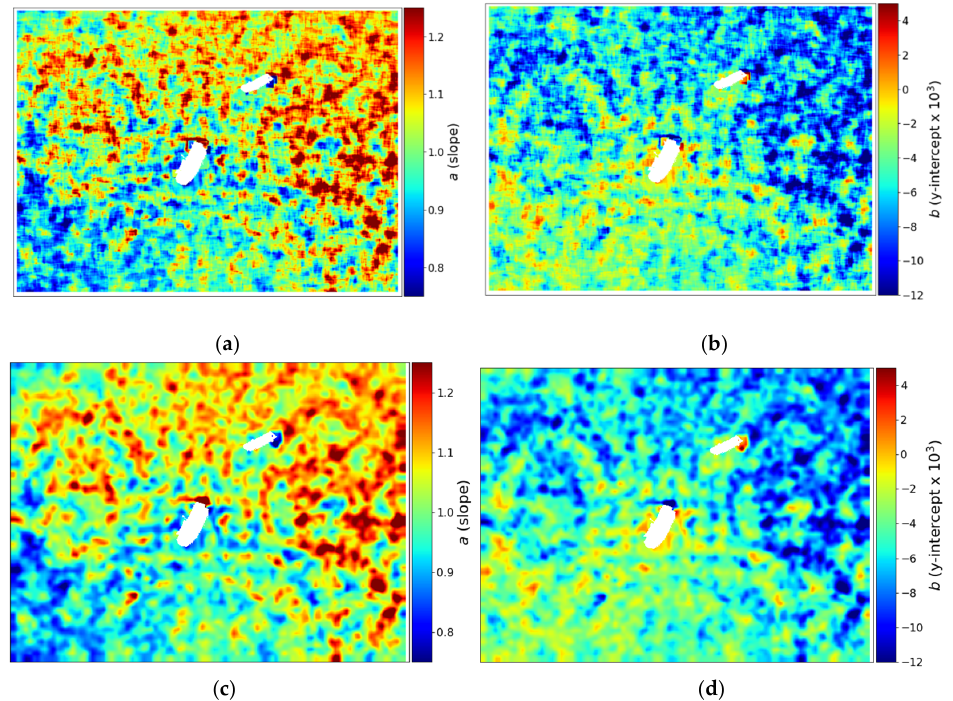
Figure 12. Images of regression slopes ( a ) and y-intercepts ( b ) that are calculated at every pixel, and the slope images ( c ) and the y-intercept images ( d ) computed in every 12 pixels and convolved with a Gaussian filter.